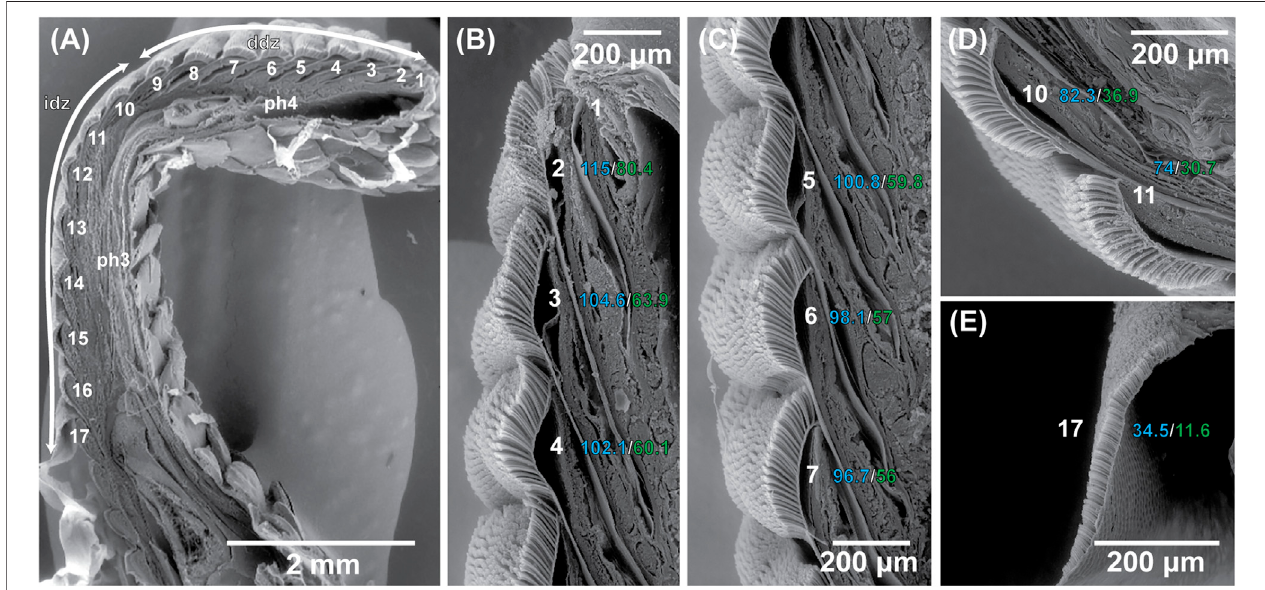
FIGURE3| Scanningelectronmicroscopicvisualizationofthesagittally-sectionedfourthdigitoftherightmanusoftheTokaygecko, Gekkogecko . (A) Visualization of theentire toe pad showing the location and relativedimensions ofthe scansors and lamellae(numbered sequentially 1 – 17from distal toproximal). The distal regionof thedigit(ddz)carriesaseries ofscansors(1 – 9)thatliebeneaththefourth phalanx(ph4).Theintermediate regionofthedigit(idz)carriesaseriesofscansorsandlamellae (10 – 17)thatliebeneathphalanx3(ph3),thetransitionfromscansortolamellaoccurringbetweenplates13and14.Lamellaearedistinguishedfromscansorsbynot being served bybranchesofthelateraldigitaltendon system. Panels (B) – (E) depict enlargements oftheindividual scansorsand lamellae,showingtherelative lengthsof theplatesandthecon fi gurationofthe fi eldsofsetaecarriedontheiroutersurfaces.Oneachplatethelengthsofthe fi lamentsdecreasefromamaximumatthedistalend to a minimum at the proximal end, and from distal to proximal along the toe pad the lengths of the fi laments decrease, although there is overlap of the span of lengths between adjacent plates. For plates 1 – 7, 10 – 11, and 17 maximum fi lament length (in µm) is indicated in blue and minimum fi lament length (in µm) in green. Data from Russell et al.